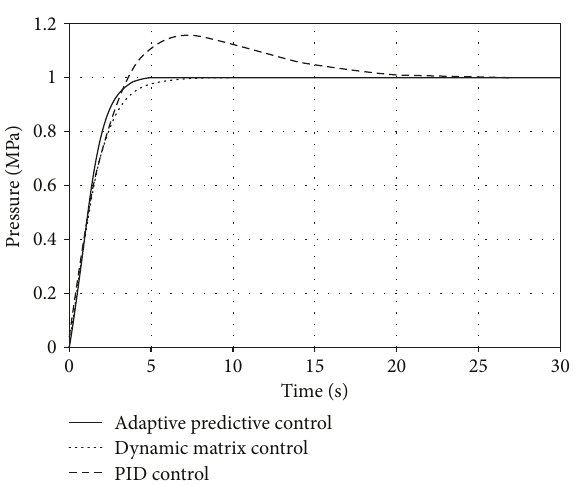
Figure 9: Response curves with di ff erent control systems under